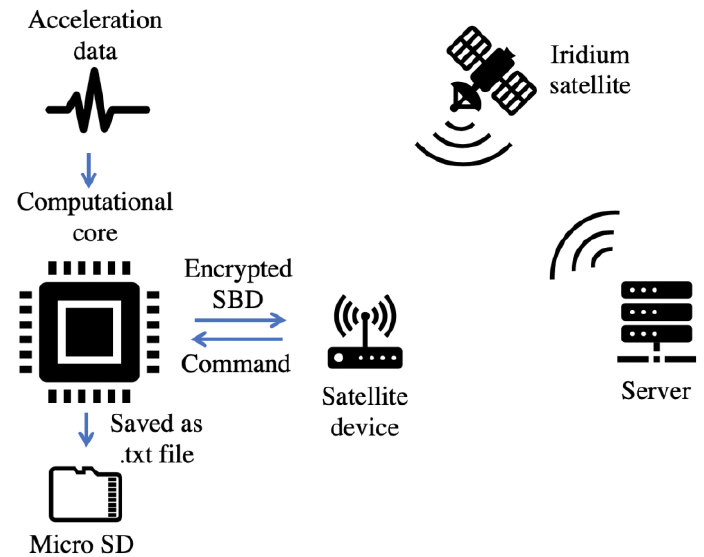
Figure 2. Schematic diagram of software architecture. SBD—short burst data.